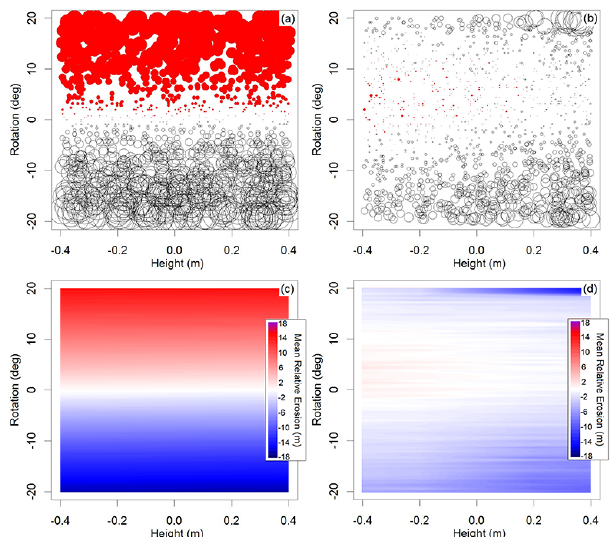
Figure 7. Wave rotation perturbation plotted against spatially aver- aged mean relative erosion for the north (a) and south (b) . Negative values indicate a reduction in the erosion rate. Wave height per- turbations are also plotted against spatially averaged mean relative erosion for the north (c) and south (d) .